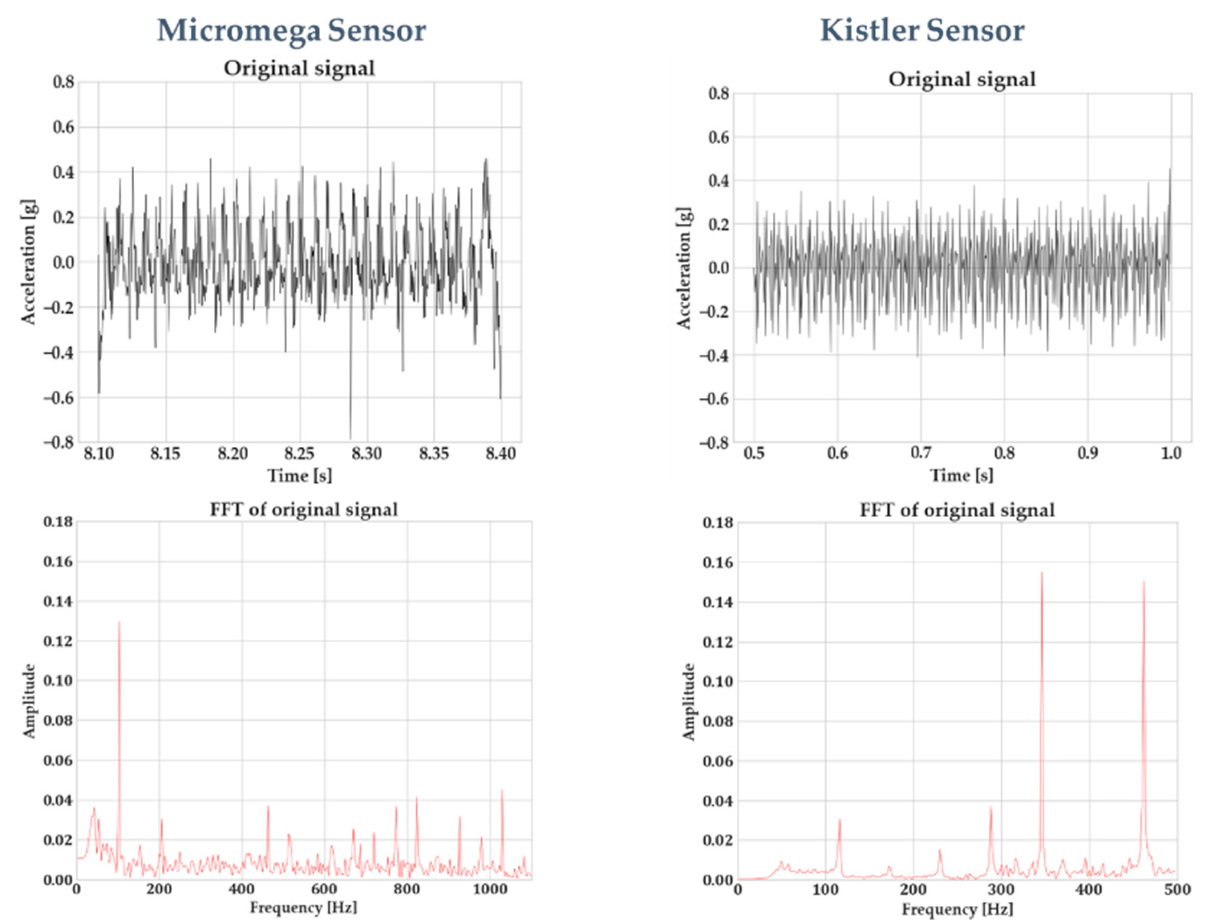
Figure 7. Difference in signal quality between Micromega and Kistler sensor.